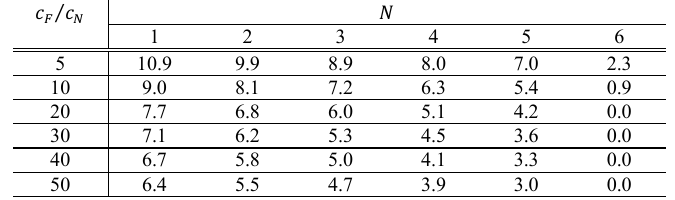
Table 5. Optimal 𝜆𝑇 0∗ when 𝜔𝐾 = 20